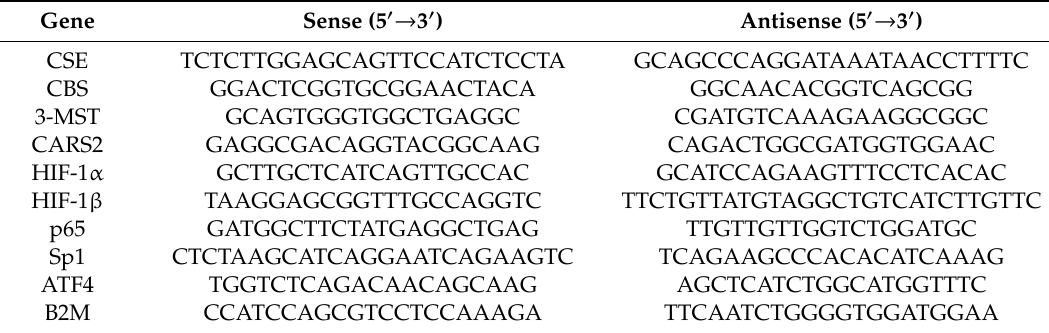
Table 2. Bovine gene-specific primers for quantitative real-time